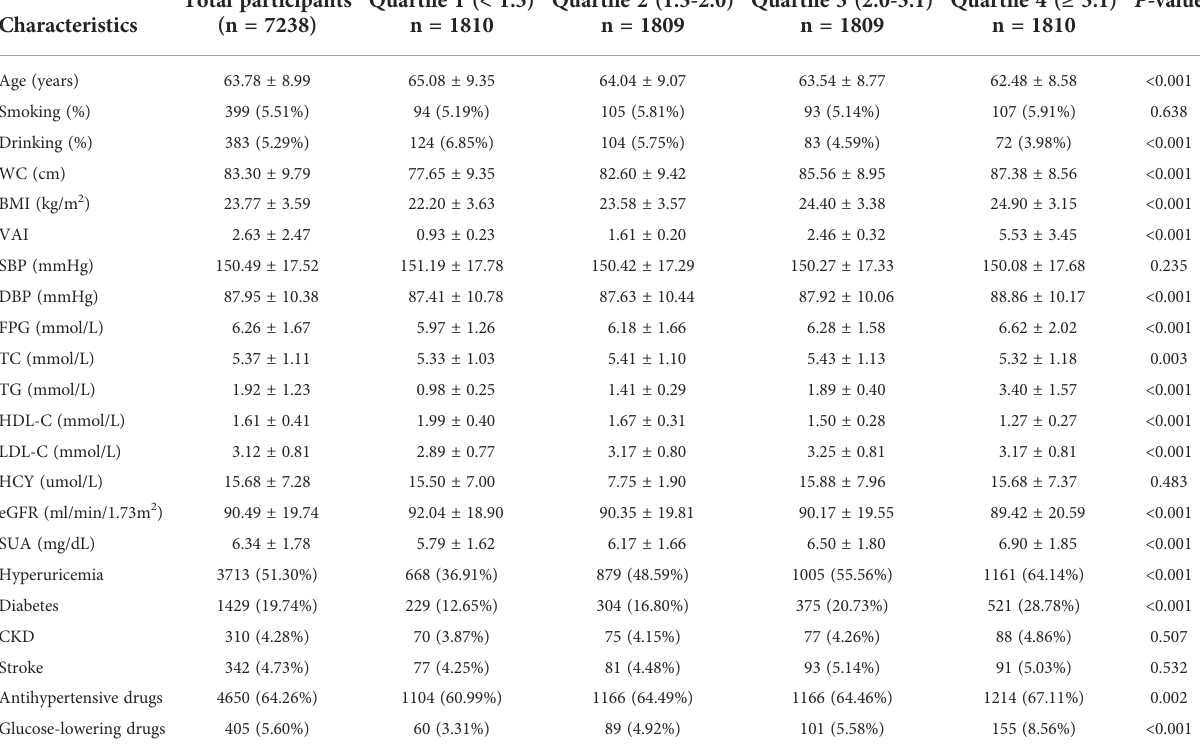
TABLE 2 Baseline characteristics of study participants across visceral adiposity index (VAI) quartiles in females.